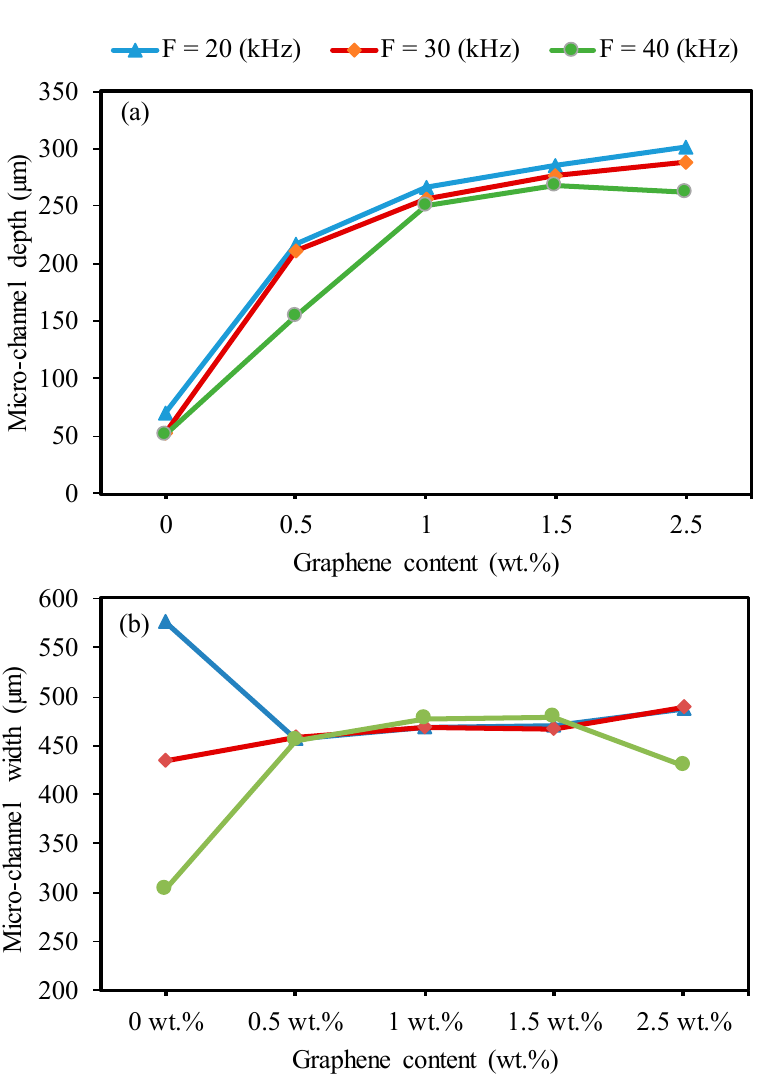
Figure 15. Effects of the graphene reinforcements and frequency on the microchannel depth for machining base Al 2 O 3 and GNP/Al 2 O 3 nanocomposites (SS = 300 mm/s). ( a ) Microchannel depth, ( b ) Microchannel depth.